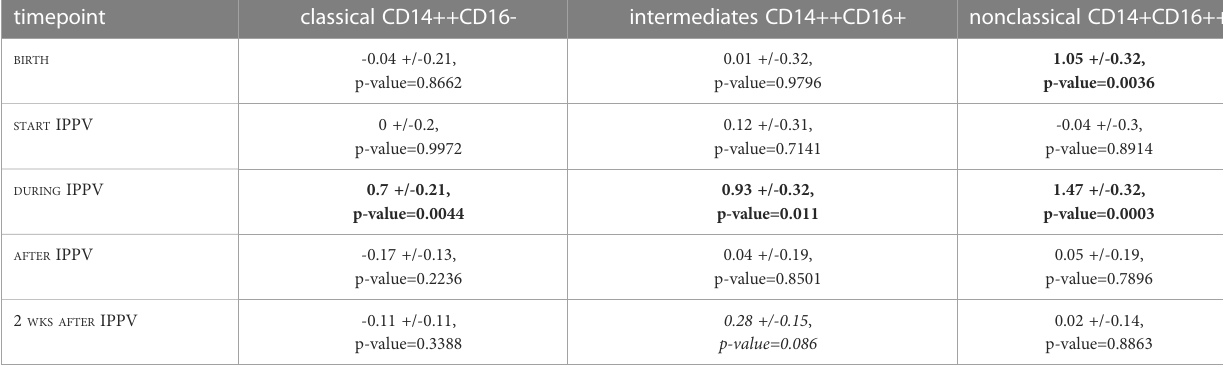
Repeated measurement analysis of variance for each monocyte subpopulation (classical, intermediate, nonclassical) with postmenstrual age as covariate.P-values and estimates for differences in log(cells)aswellasstandarddeviationofcomparisonofBPD(n=15)vsnoBPD(n=15)aredisplayedforeachtimepoint.Boldvaluesshowsigni fi canceata95%-signi fi cancelevel;p-values<0.05.